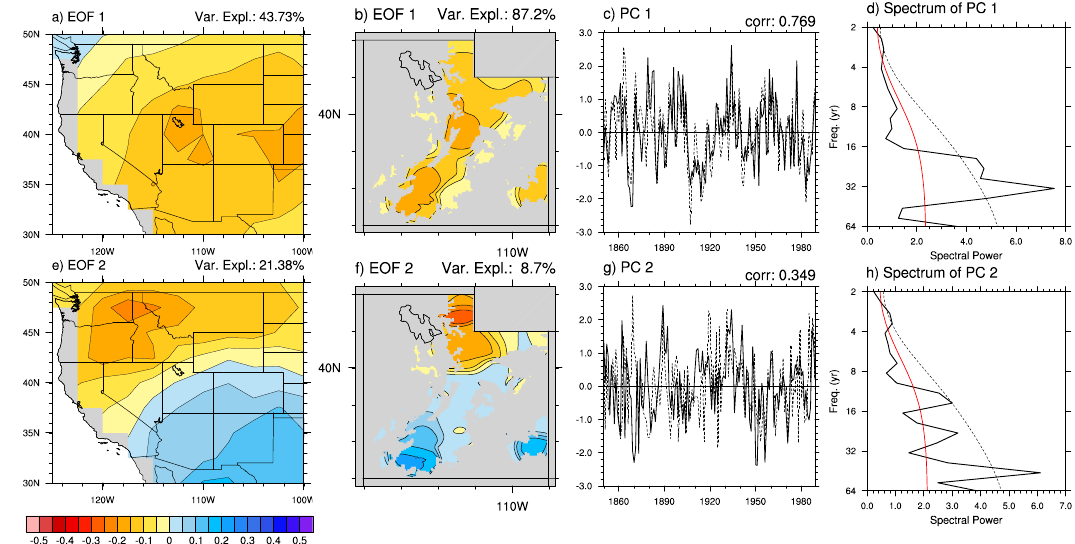
Figure 5. ( a ) EOF 1 for NADA; ( b ) EOF 1 for FIA; ( c ) PC1 of reconstructed SWE for ( a , b ) (solid: FIA, dashed: NADA); and ( d ) spectral power of FIA PC1. In ( d ), the red line depicts the red noise spectrum and the dashed line indicates red noise exceedance at 95% confidence. ( e – h ) Same as ( a – d ) but for EOF 2 and FIA PC 2.